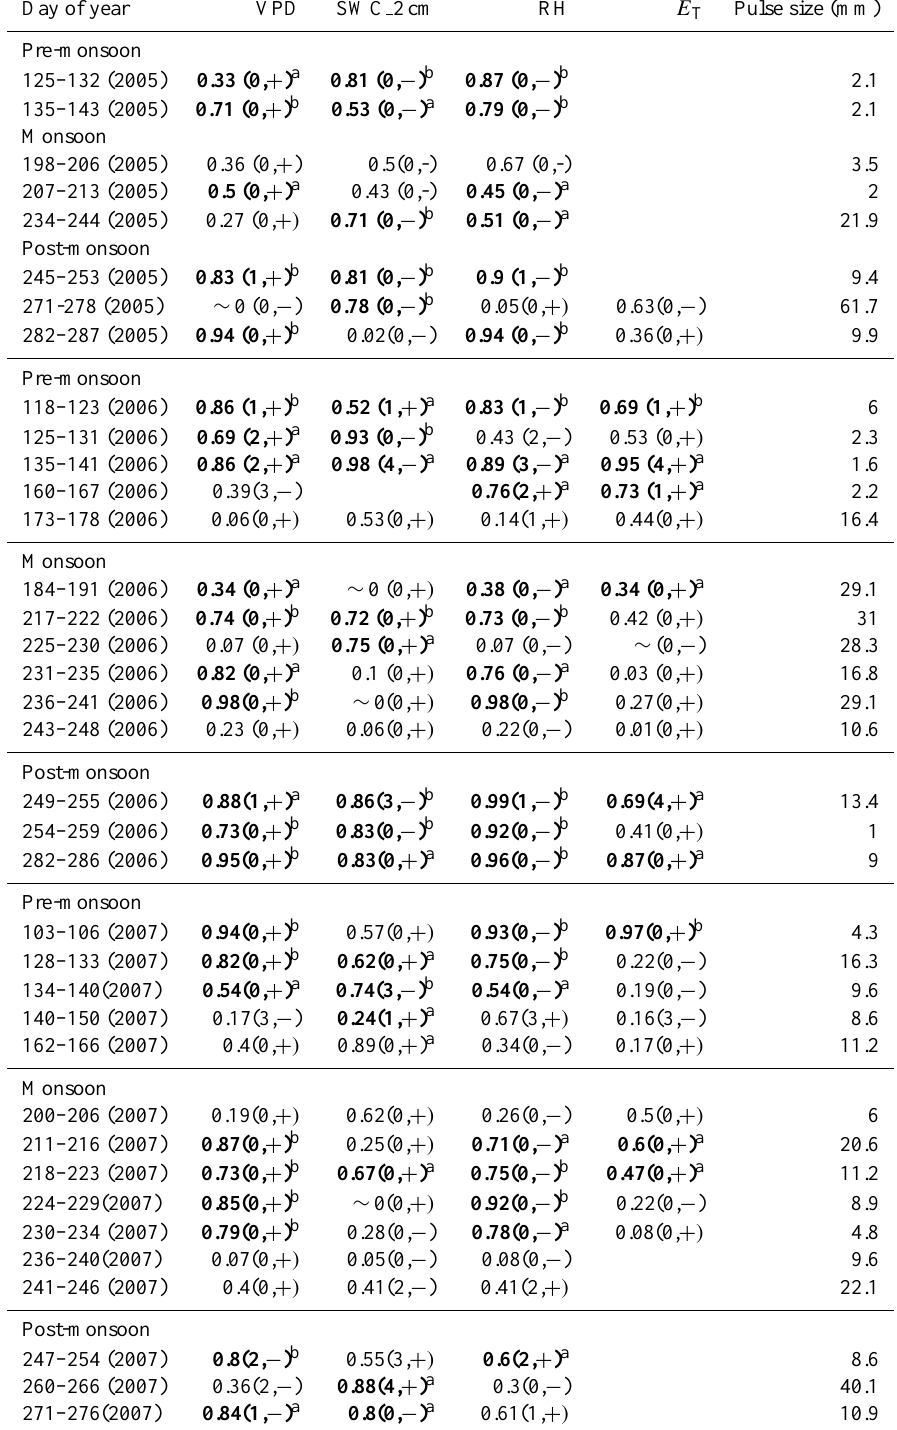
Table 2. Correlation coefficients ( r 2 ) of δ R with VPD, SWC, RH, and E T for each pulse event. The number of days lagged is presented along with the sign of relationship in parentheses. a Regression significance: p ≤ 0.1. b Regression significance: p ≤ 0.05. Blanks: data not available. Horizontal dashed lines indicate season shifts between pre-monsoon, monsoon, and